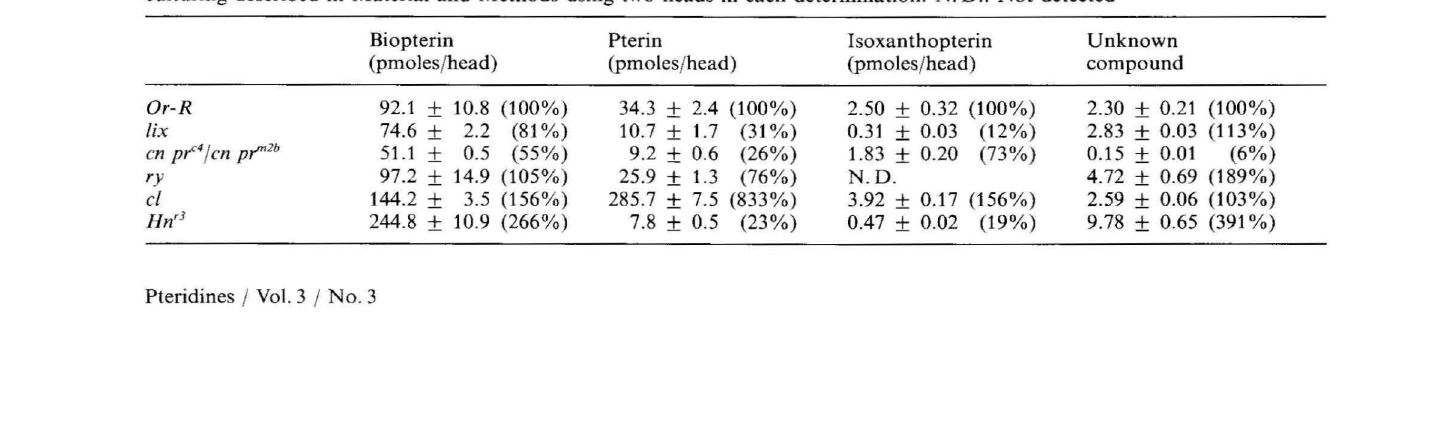
Table 1. Pteridine levels in 9 day old heads of some strains of Drosophila melanogaster. The figures are the mean and its standard error of three determinations, also percentage of Or-R values are given in parenthesis. The unknown compound has 16.8 min of retention time and its measurement is given in arbitrary fluorescence units. Analyses were made following the protocol for head culturing described in Material and Methods using two heads in each determination. N. D.: Not